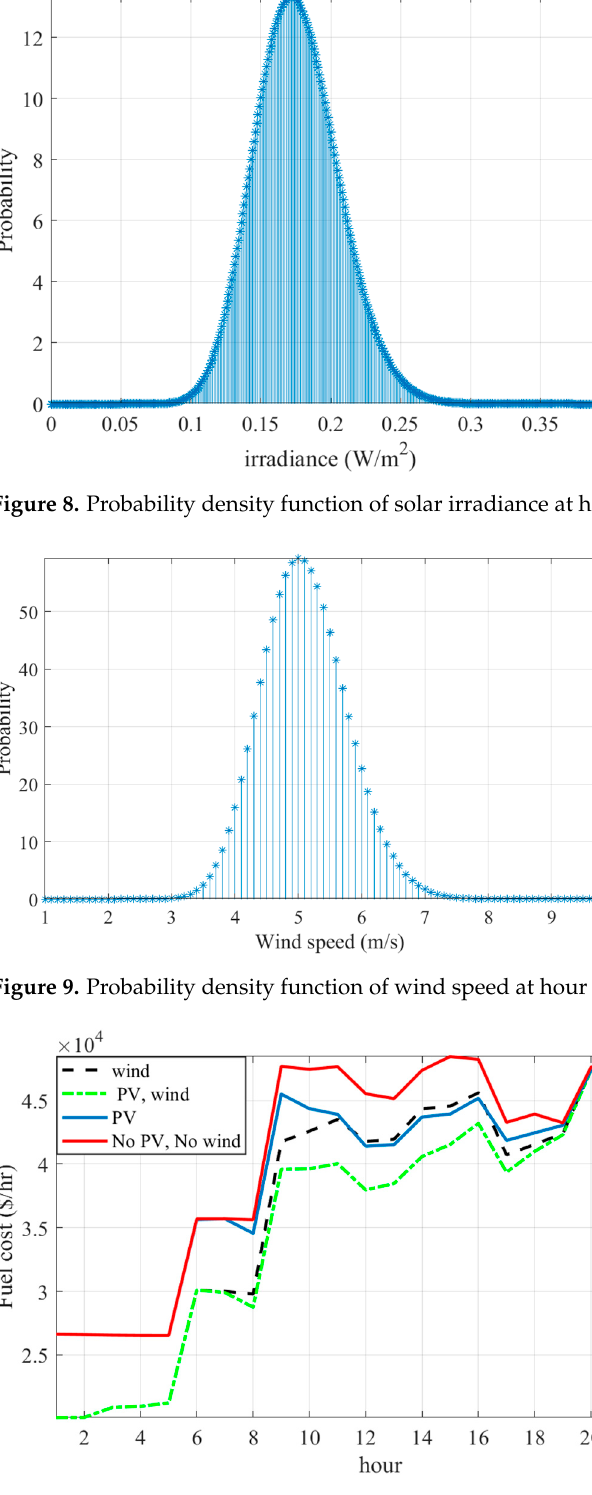
Figure 10. Cost variations of the 57-bus test network.